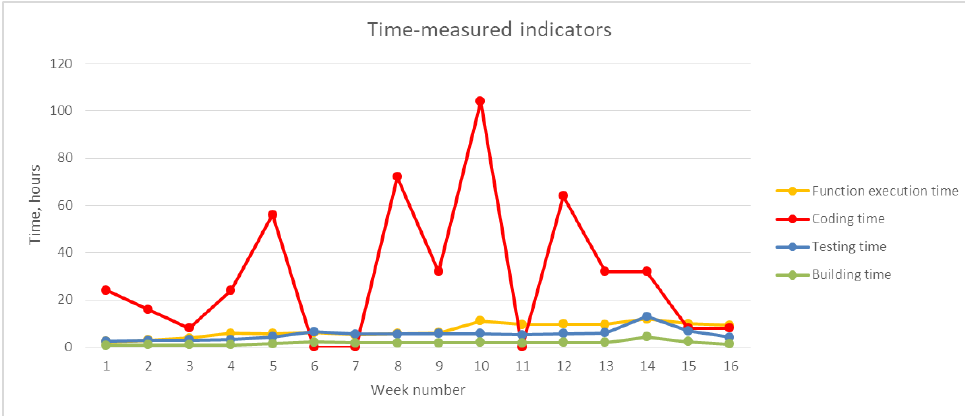
Figure 5. Time series of time-measured